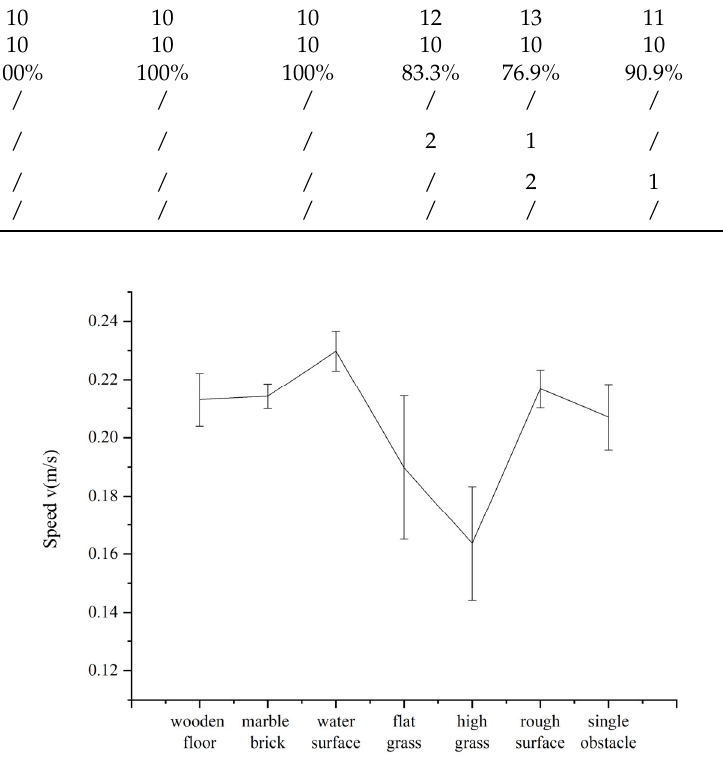
Figure 9. Comparison of average forward speeds on different surfaces.